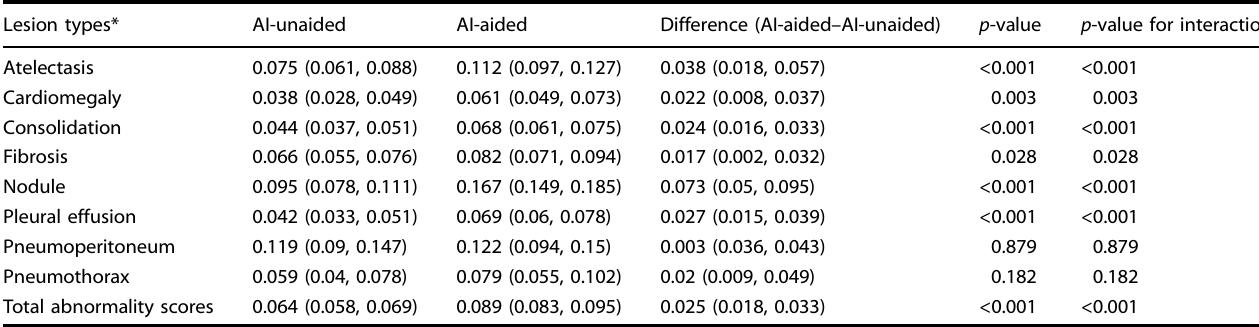
Table 4. Comparison of reading times according to abnormality